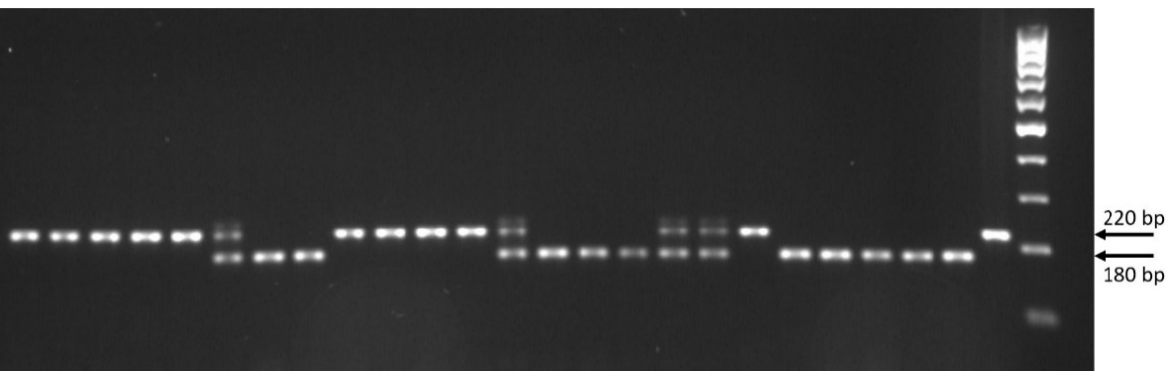
Figure 2. Application of the allelic-specific STS marker for the ScGrf3-2R gene. An example of elec- trophoresis of PCR products amplified from DNA of spring triticale F 3 plants of the hybrid combination Dublet x Valentin 90. M-100-5 (ZAO Sintol, Moscow, Russia) was used as a molecular weight marker. Expected amplicon sizes: 220 bp for ScGrf3-2Ra , 180 bp for ScGrf3-2Rb .